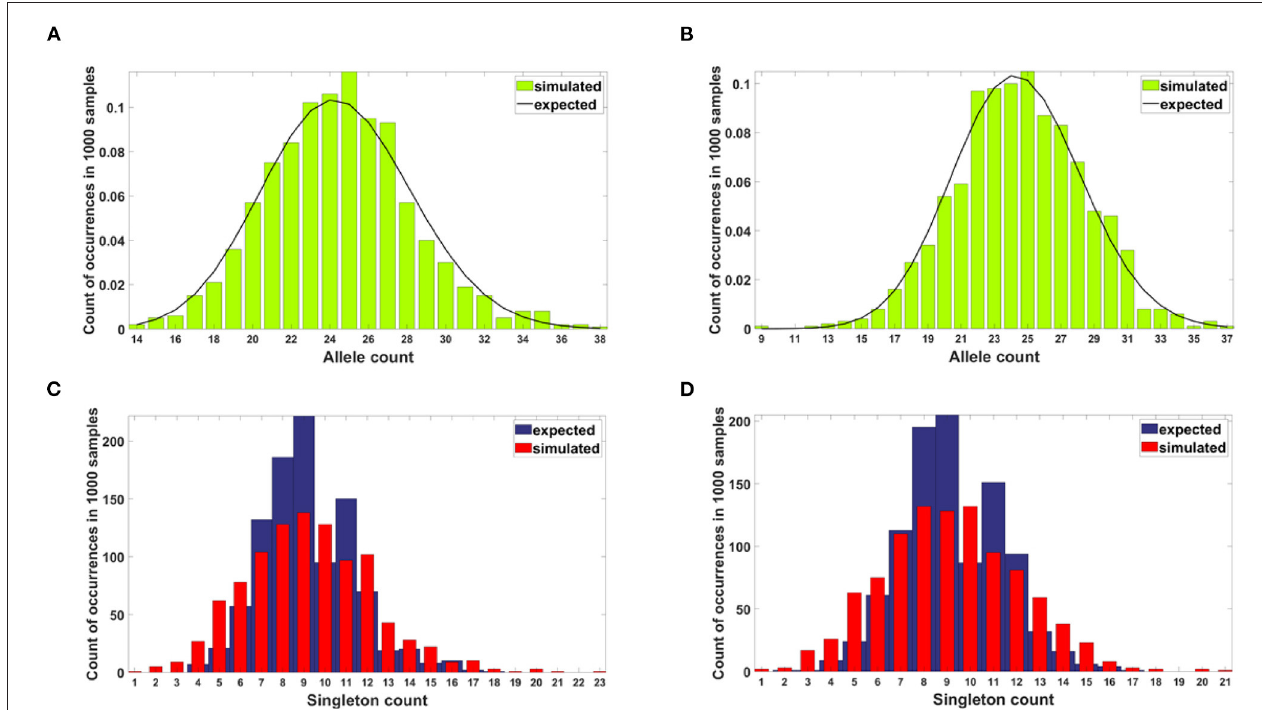
FIGURE 11 | Results of neutrality testing for allele counts (top panels) and singleton number (bottom panels) calculated for simulations with parameters: s = 0, d = 0, µ = 0.1, p = 0.5. (A) Model A. One-sample Kolmogorov-Smirnov test does not reject the null hypothesis that the empirical distribution of allele count fits the expected one at the 5% significance level ( p = 0.62). (B) Model B. One-sample Kolmogorov-Smirnov test does not reject the null hypothesis that the empirical distribution of allele count fits the expected one at the 5% significance level ( p ≈ 1). (C) Model A. Two-sample two-sided Wilcoxon test does not reject the null hypothesis that simulated and expected singleton counts come from distributions with equal medians at 5 % significance level ( p = 0.48). (D) Model B. Two-sample two-sided Wilcoxon test does not reject the null hypothesis that simulated and expected singleton counts come from distributions with equal medians at 5 % significance level ( p =